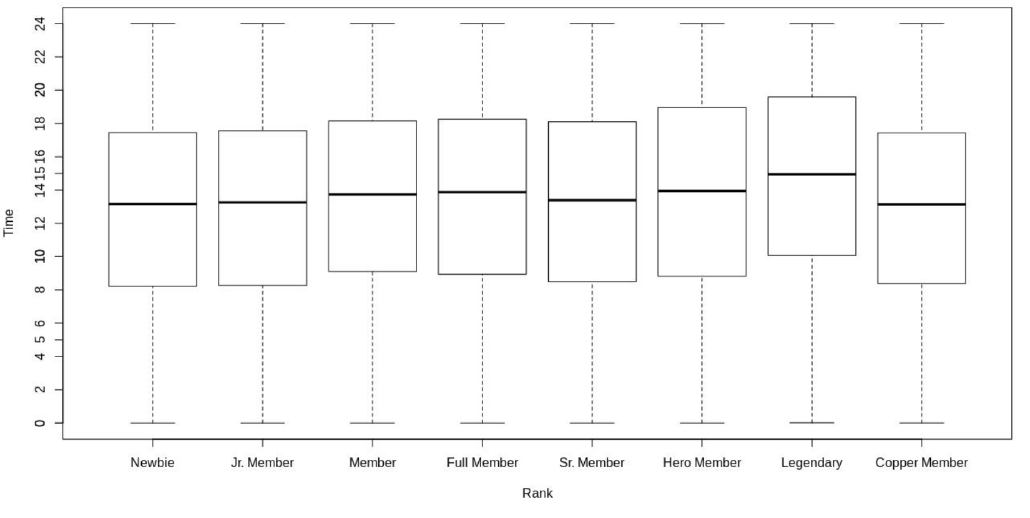
Figure 4. The influence of time of